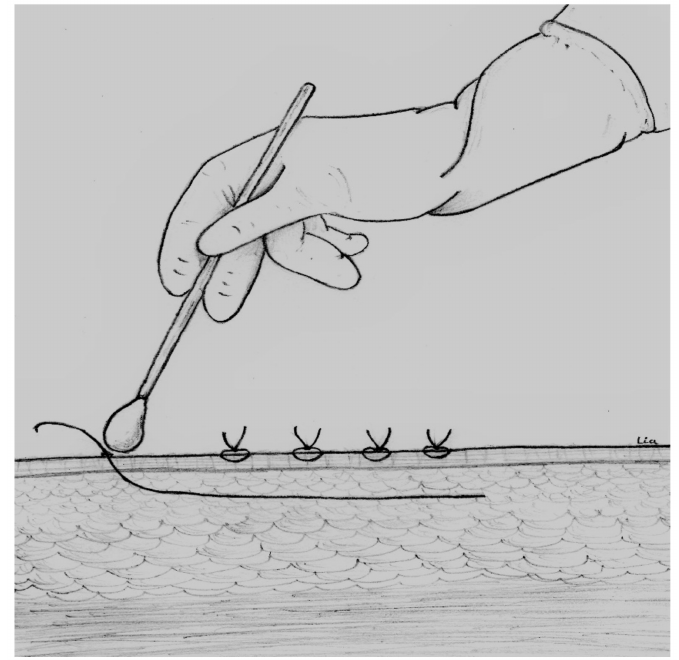
Figure 1. Wound swab at the cutaneous exit point of the suture thread.